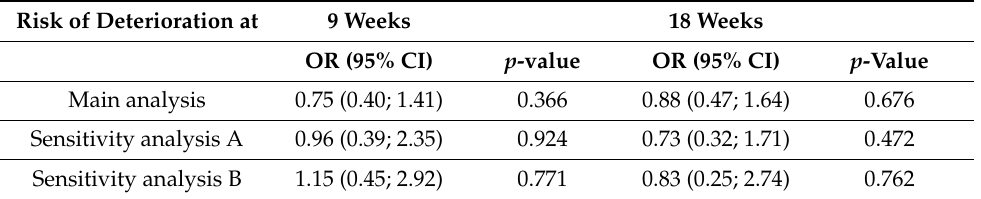
Table 4. Risk of deterioration based on ECOG PS deterioration at 9-week and at 18-week follow-ups. Risk of Deterioration at